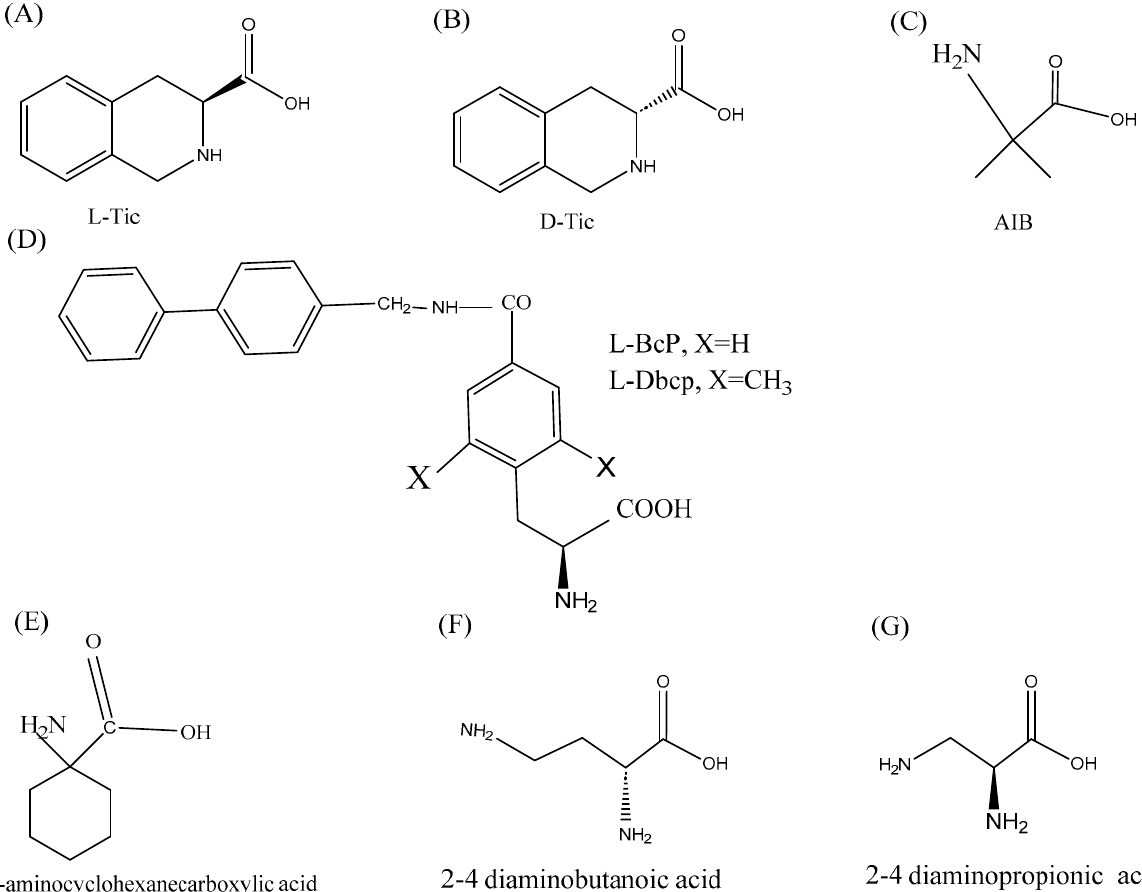
Figure 2. ( A – G ), Non-natural amino acid analogs and chemical compounds that can be used to alter the secondary structure and improve the anti-cancer activity of the